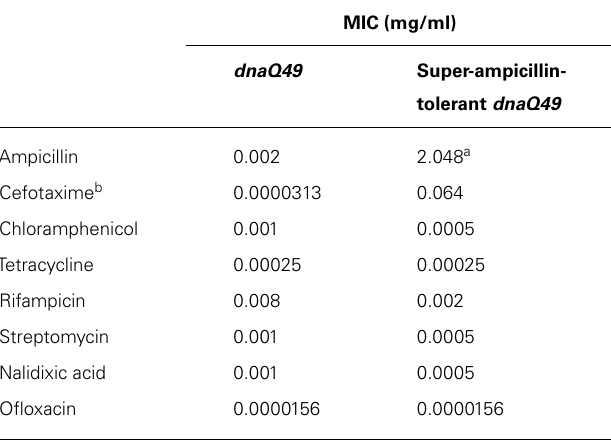
Table 2 | Sensitivity of super-ampicillin-tolerant dnaQ49 to other antibiotics.